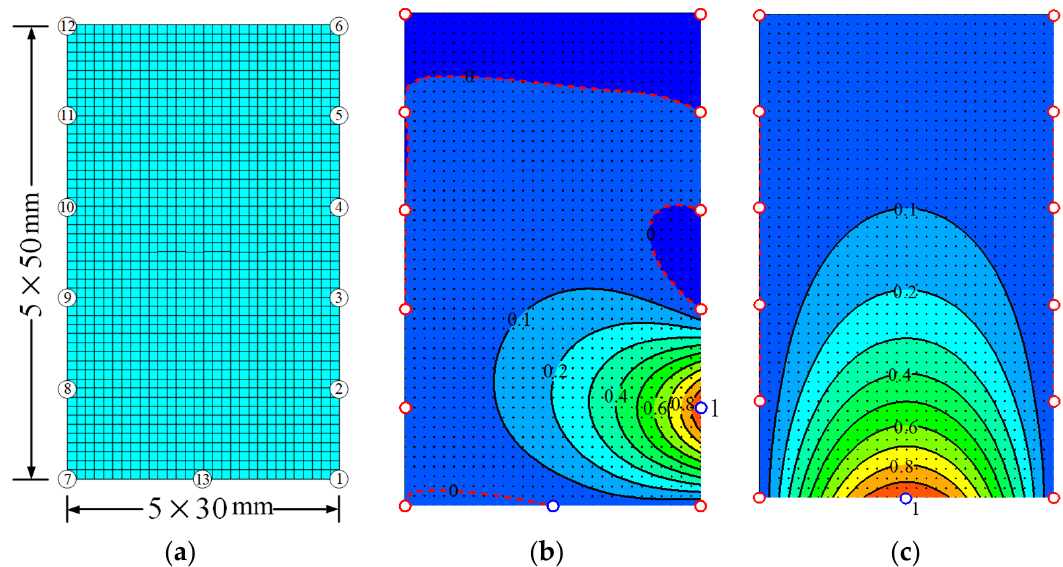
Figure 10. Finite element model and contour map of numerical shape function. ( a ) Finite element model. ( b ) Shape function N 2 . ( c ) Shape function N 13